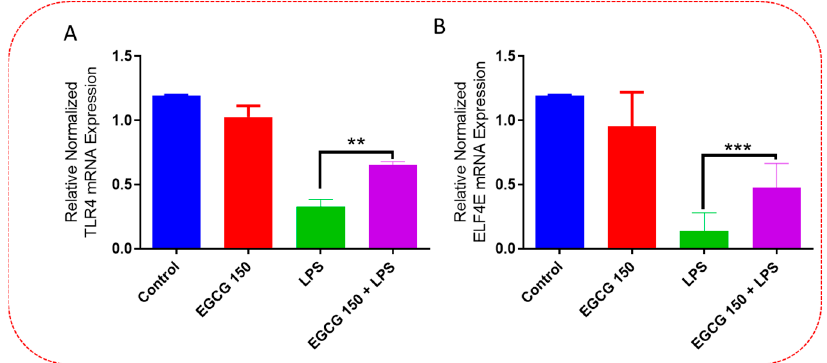
Figure 9. EGCG upregulated immunosurveillance PI3k-AKT genes. PCR array investigation demonstrated that EGCG 150 µM coupled with LPS (1 µg/mL) raised mRNA expression of TLR4 ( A ) and ELF4E ( B ) compared to LPS. Values represent the mean ± SD, ** p ≤ 0.01, and *** p ≤ 0.001 vs. LPS.